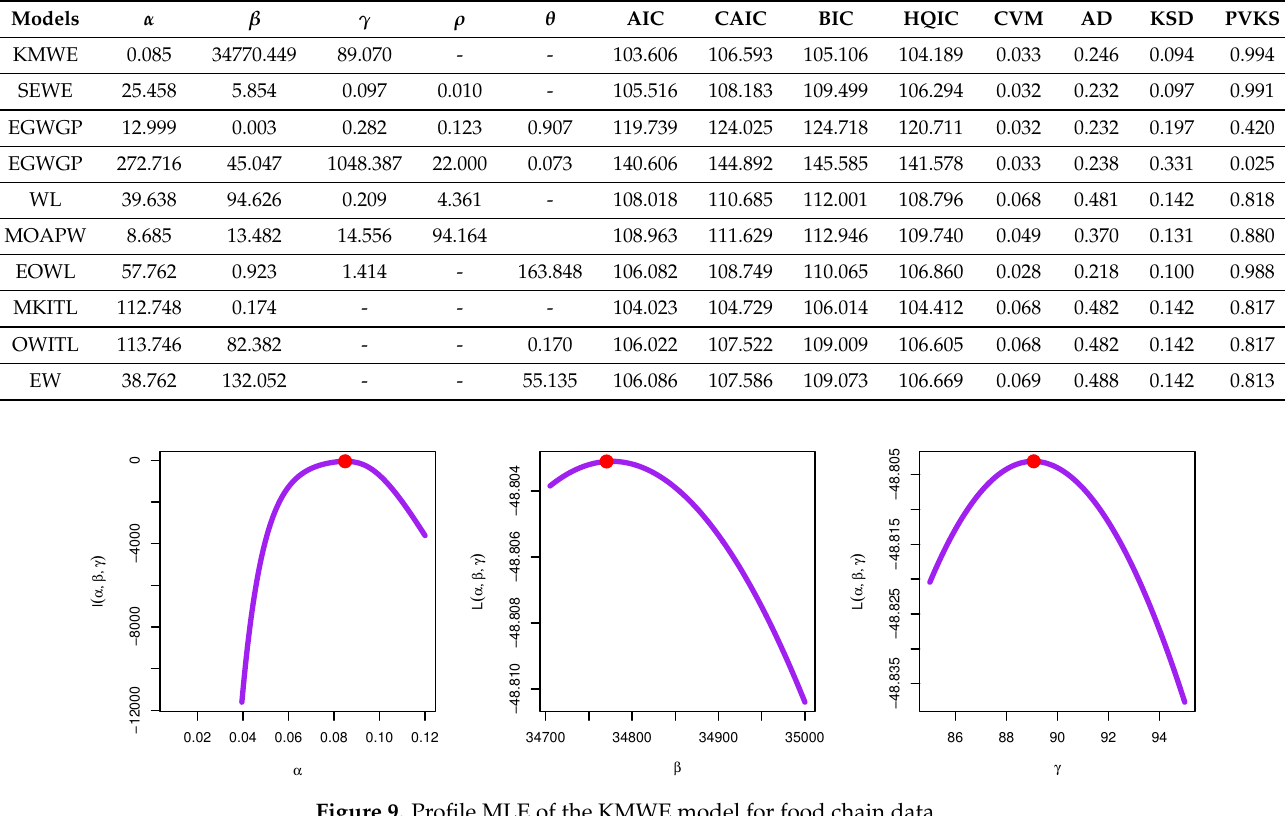
Figure 9. Profile MLE of the KMWE model for food chain data.